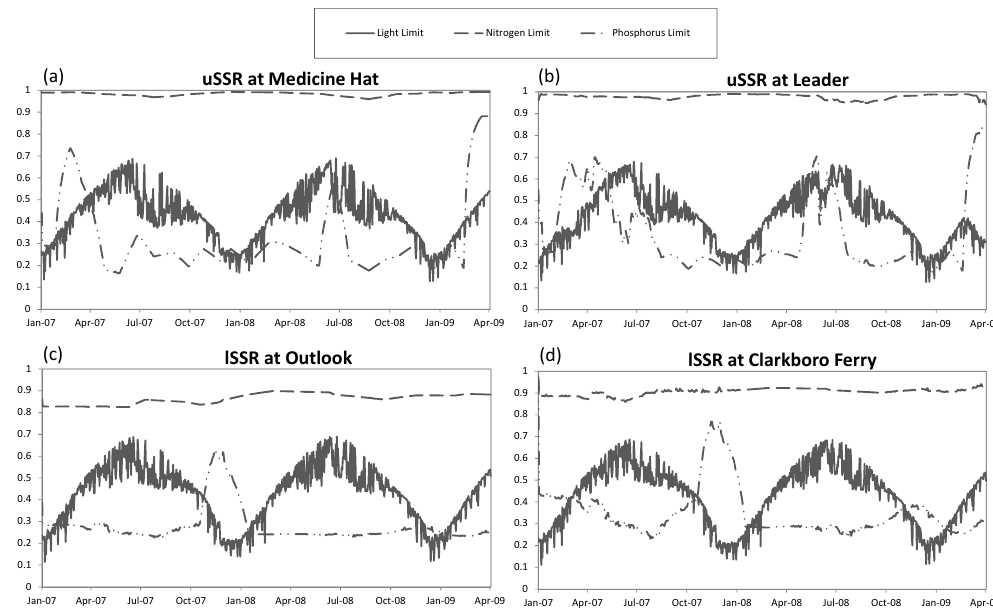
Figure 4. Nutrient and light limitations for the best performing simulation. ( a ) uSSR at Medicine Hat; ( b ) uSSR at Leader; ( c ) lSSR at Outlook, and ( d ) lSSR at Clarkboro Ferry.